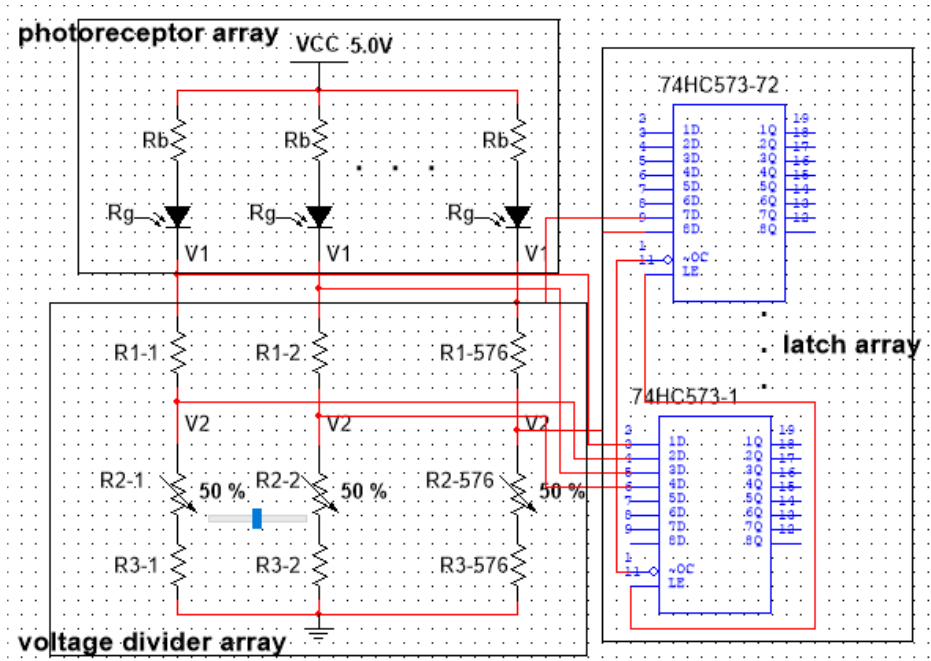
Figure 6. The 576-bit parallel decoder circuit.